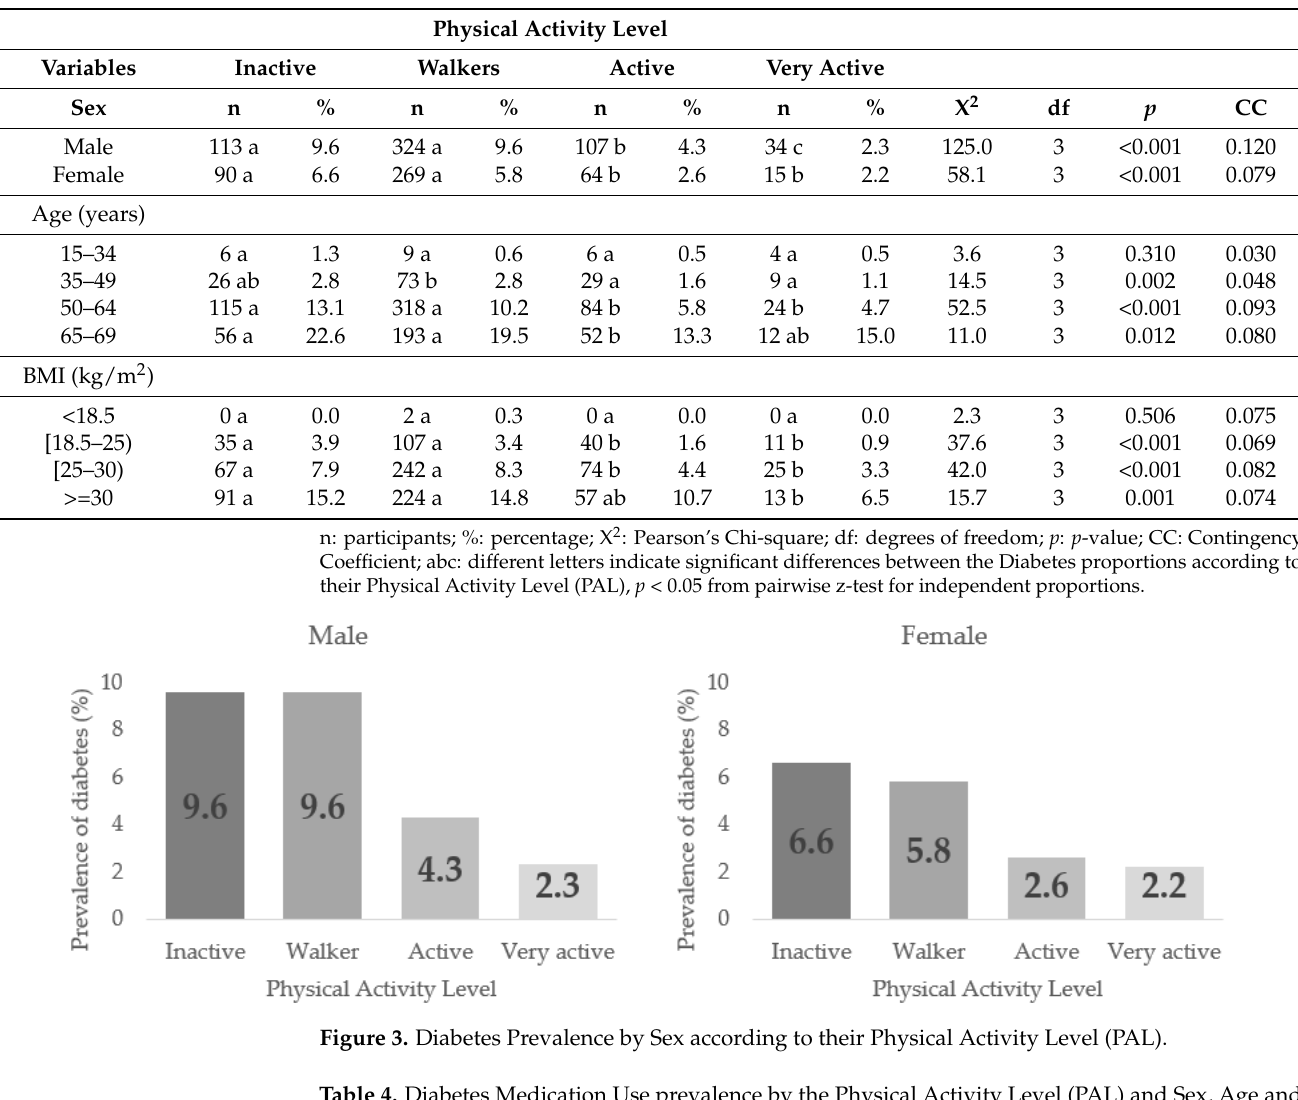
Table 3. Diabetes prevalence through the Physical Activity Level (PAL) according to Sex, Age, and Body Mass Index (BMI).